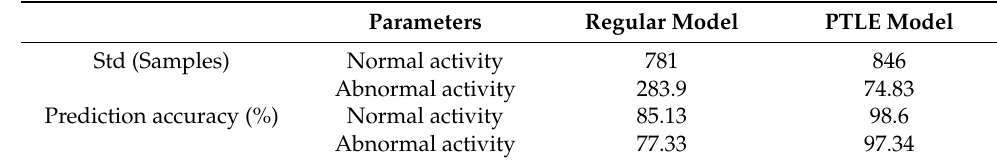
Table 5. Correct prediction comparison metrics.